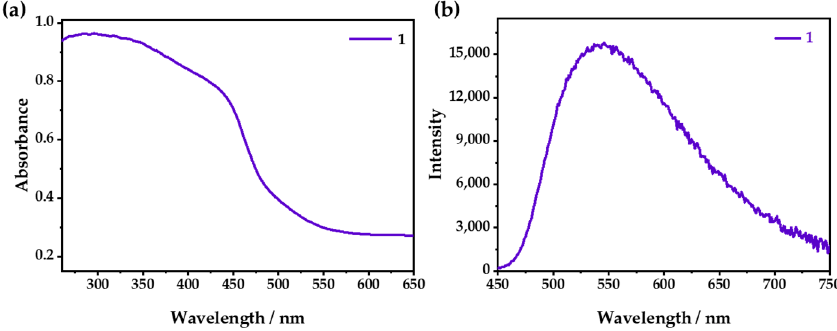
Figure 3. ( a ) UV–vis absorption and ( b ) emission spectra of 1 when excited at 365 nm. The PXRD patterns of 1 and 1 · g were almost the same, indicating that they had very similar structures (Figure S3). However, λ em of 1 was located at 542 nm (Figure S5), and it showed a redshift of 18 nm compared with that of 1 · g ( λ em = 524 nm). The emission of 1 could be quenched due to the tiny number of channels in the structure, which could allow the entry of O 2 . With the increase in oxygen concentration, the luminescence was gradually weakened; furthermore, 98.4% of the luminescence intensity was quenched at 1 bar O 2 (Figure 4a and Figure S6), which was relatively low in comparison with Cu(I) CPs, and this was because of its small cavities [36,37]. However, it was difficult for O 2 to enter the zero-dimensional channels quickly, so it needed a relatively long time to capture O 2 and reach a balance. As shown in Figure 4b, it was demonstrated that the luminescence attenuation was less than 10% after 10 cycles in the O 2 -sensing test. The Stern–Volmer curve was obtained with the fluorescence spectra at different O 2 pressures and fitted according to the equation: I 0 / I = τ 0 / τ = 1 + K SV P O 2 . The fitting chart exhibited good linearity, and the K SV value was calculated as 62 bar − 1 (Figure 4c), indicating that 1 had excellent O 2 - sensing performance, with a high sensitivity and good stability. The luminescence of 1 · g could be also quenched by oxygen, but it showed a very low quenching efficiency because the CH 3 OH guest occupied the cavities of 1 , which prevented the entry of the oxygen (Figure S7).